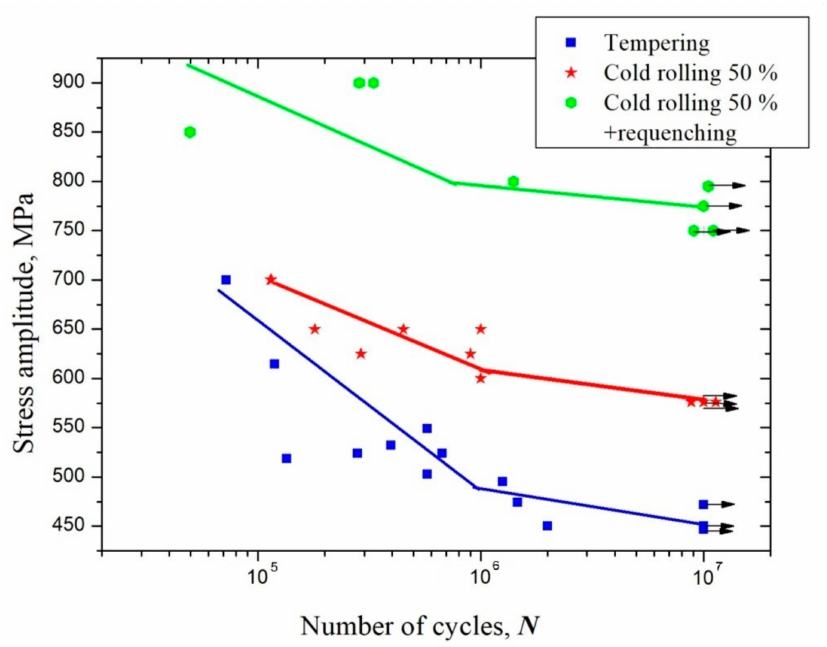
Figure 5. S–N diagram of the behavior of the ferritic–martensitic steel (include the grade here). To analyze the nature of fatigue failure, a fractographic analysis of fracture surface relief was carried out. At the fracture surface of both CR and CR + requenched samples, a smooth zone depicting the fatigue crack propagation and a rupture zone is clearly visible (Figure 6). Figure 6a shows the rupture of the sample after CR at a load of 750 MPa after 1.5 × 10 6 cycles with the fatigue crack inclined to nucleate at the surface of the material. The TEM analysis showed that zone 1 (Figure 6a, zone 1) is characterized by scars located in the direction of crack propagation, and the microstructure of this zone reveals a 0.9 mm wide plateau with fatigue grooves, the width of which reaches 30 microns (Figure 7a). The zone of crack propagation is characterized by the presence of facets and grooves. At larger magnifications (i.e., × 1000), an intergranular fracture is observed and secondary cracks are visible (Figure 7b). The failure in the rupture zone occurred visibly with the formation of pits. The sizes of the pits were from 1 to 5 microns, inside which particles of 0.5–2 microns were observed, and the width of the zone was 0.5 mm (Figure 7d).